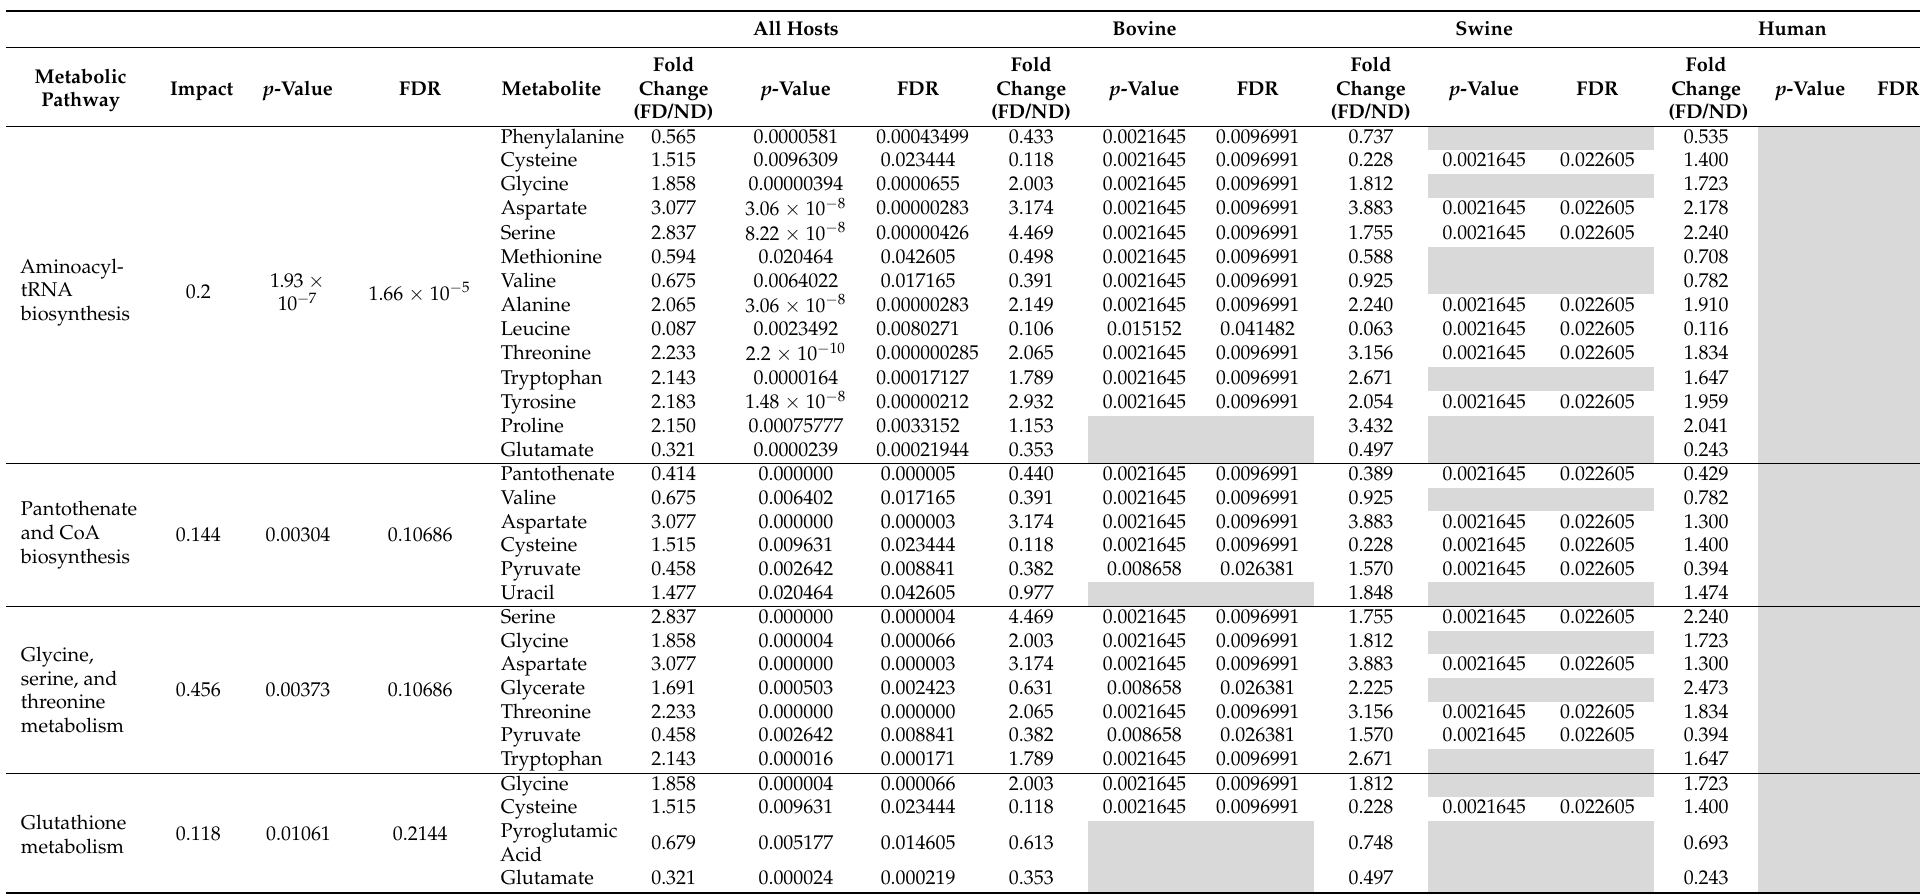
Table 2. Significant metabolites from the Wilcoxon rank-sum test with the metabolic pathway and the associated fold changes observed across host species. All Hosts Bovine Swine